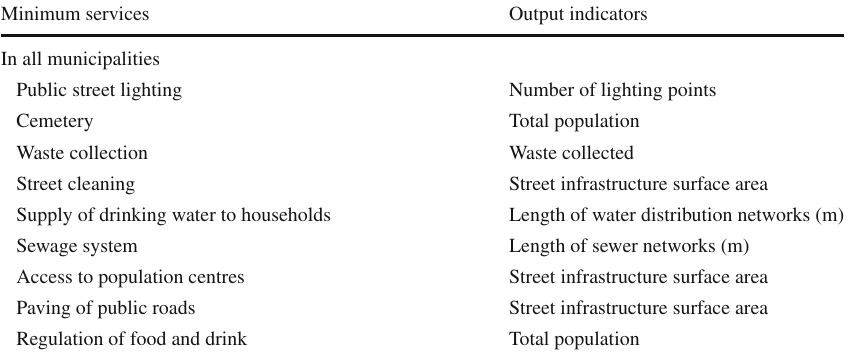
Table 4 Minimum services provided by all local governments and output variables